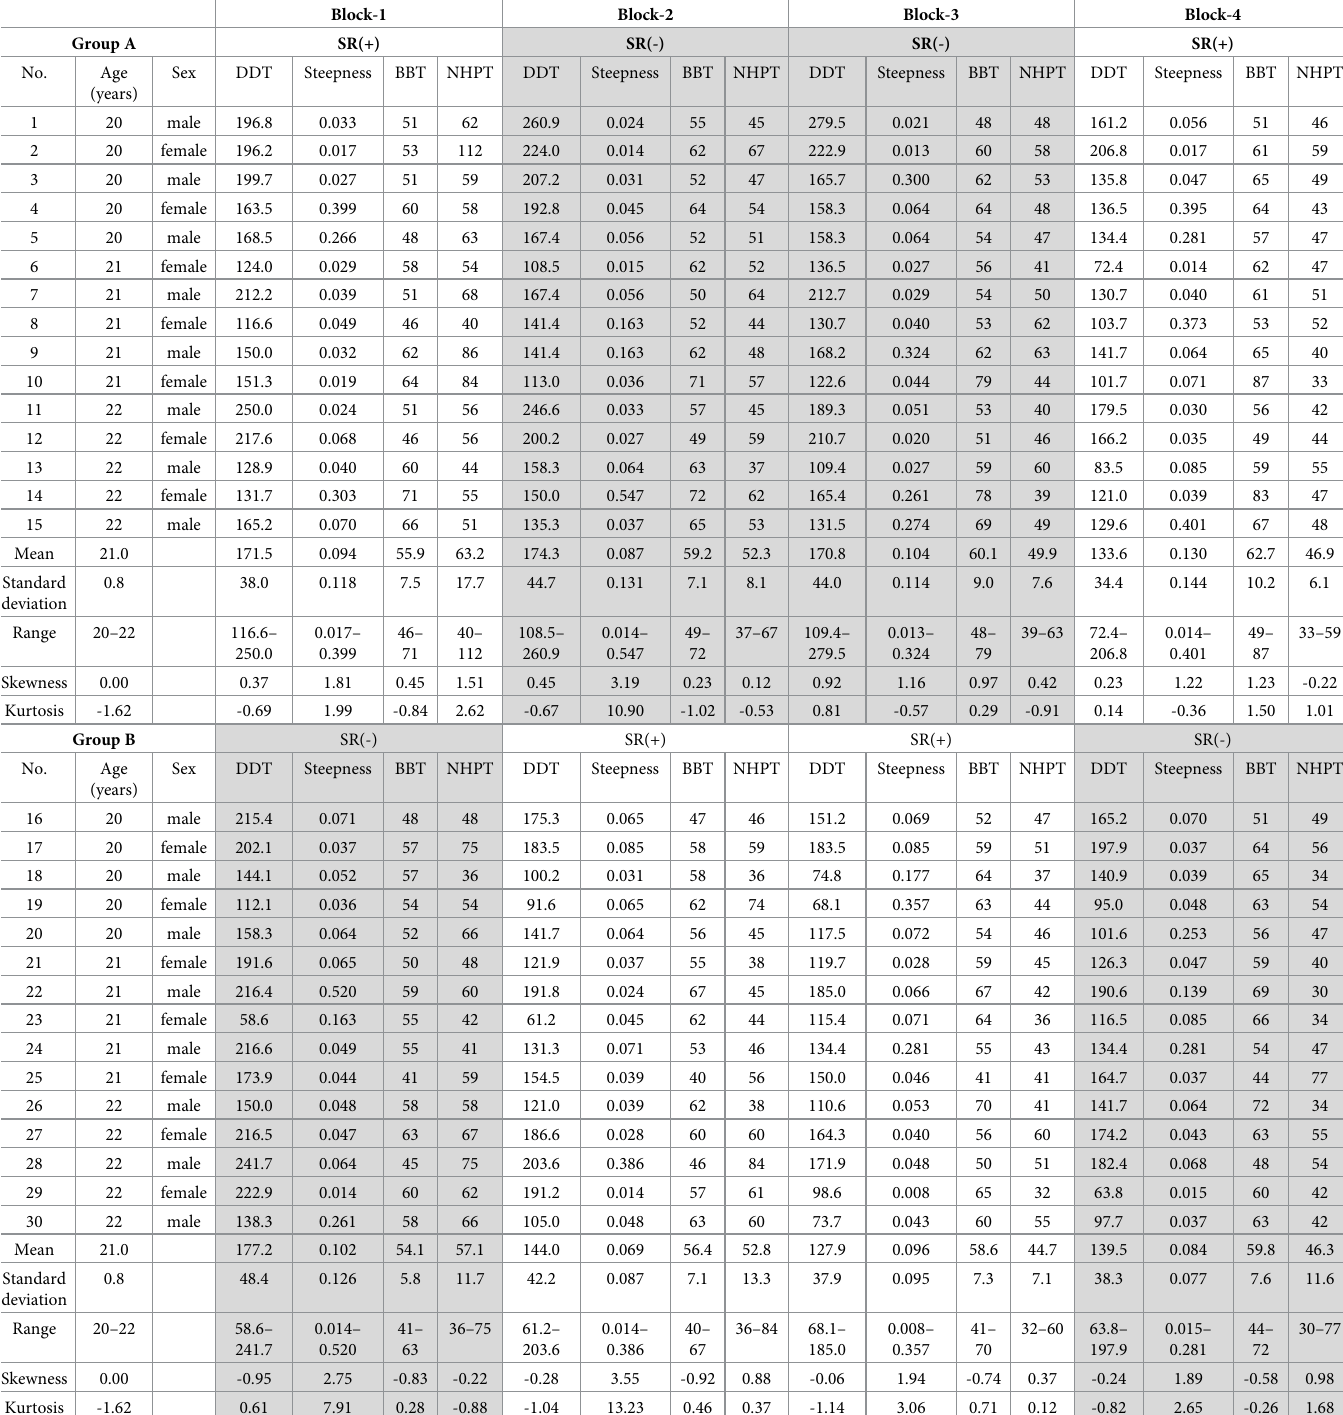
Table 1. Raw data of the four indicators of the four blocks in all